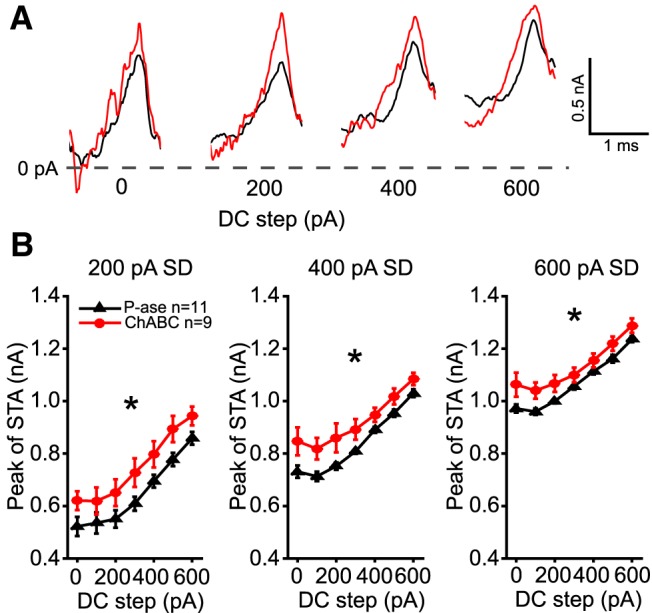
STAs of injected currents reveal higher current threshold in ChABC-treated MNTB neurons. Injected currents that triggered spikes were aligned and averaged. A, Overlaid examples of P-ase-treated (black) and ChABC-treated (red) cells at the 400 pA SD noise level superimposed on four DC current steps. The peaks of the action potentials were aligned with the rightmost point of each STA. Note that in these examples the peak of the STA is higher in the ChABC-treated cell than in the P-ase-treated cell. B, The average STA peak across cells was significantly higher among the ChABC-treated cells than the P-ase-treated cells (*two-way RM ANOVA, p < 0.05). Error bars are the mean and SEM.